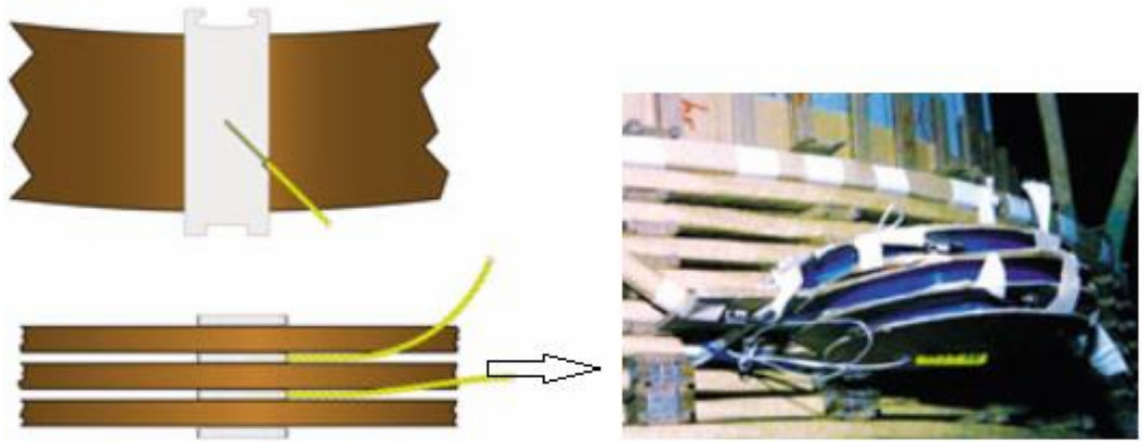
Figure 4. Fibre optic probe mounted adjacent to the top of the